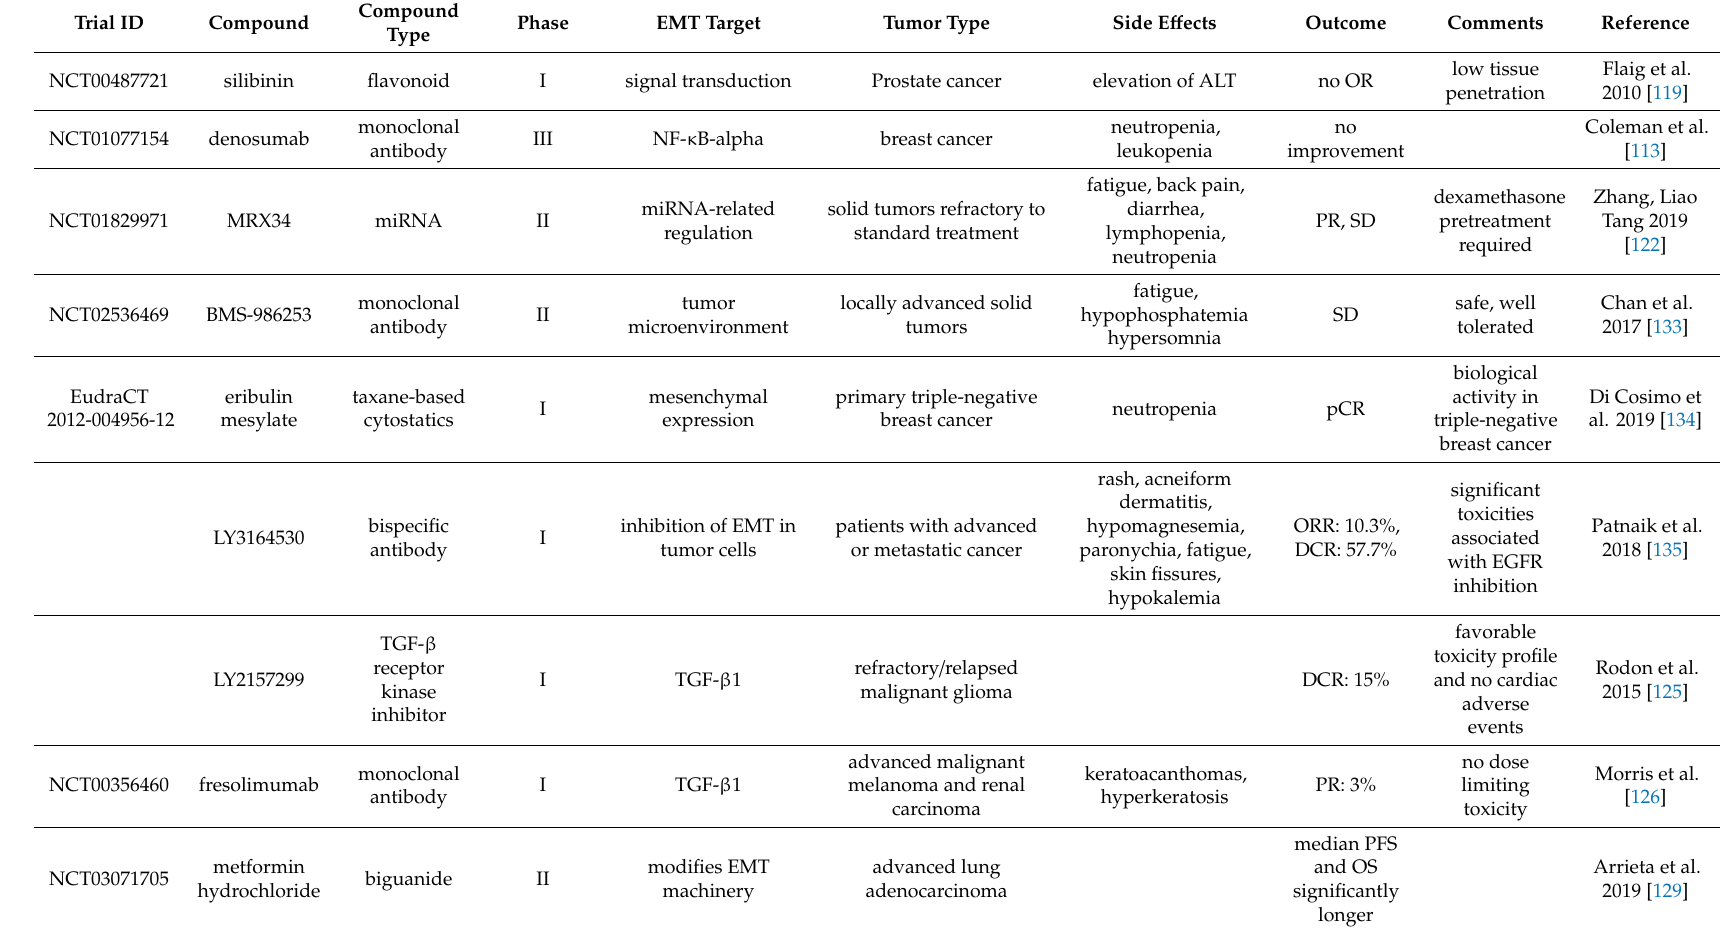
Table 1. Examples of clinical trials targeting